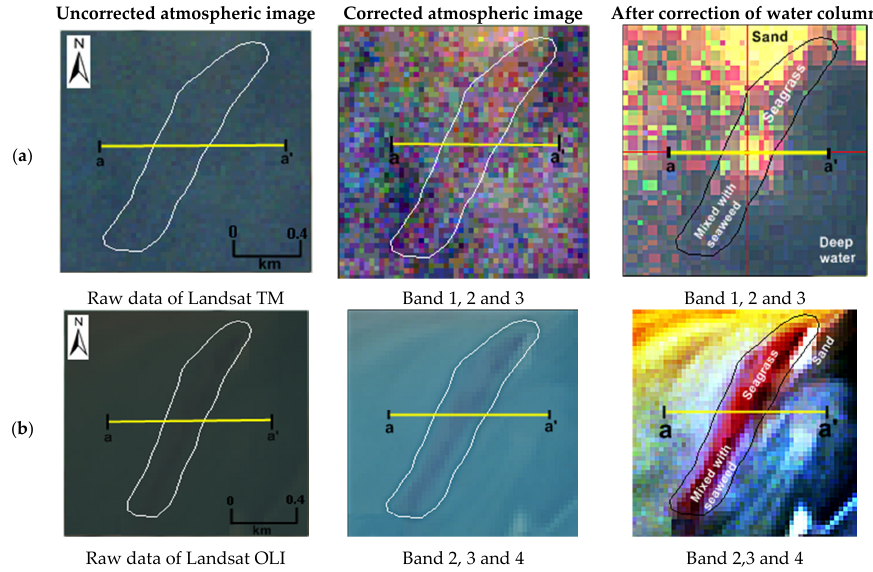
Figure 6. Visual appearance of both Landsat 5 TM ( a ) and Landsat 8 OLI ( b ) before and after atmospheric and water column corrections. The RGB color composite is created by layer stacking R: band 3, G: band 2, B: band 1 for Landsat 5 TM while R: band 4, G: band 3, B: band 2 for Landsat OLI.